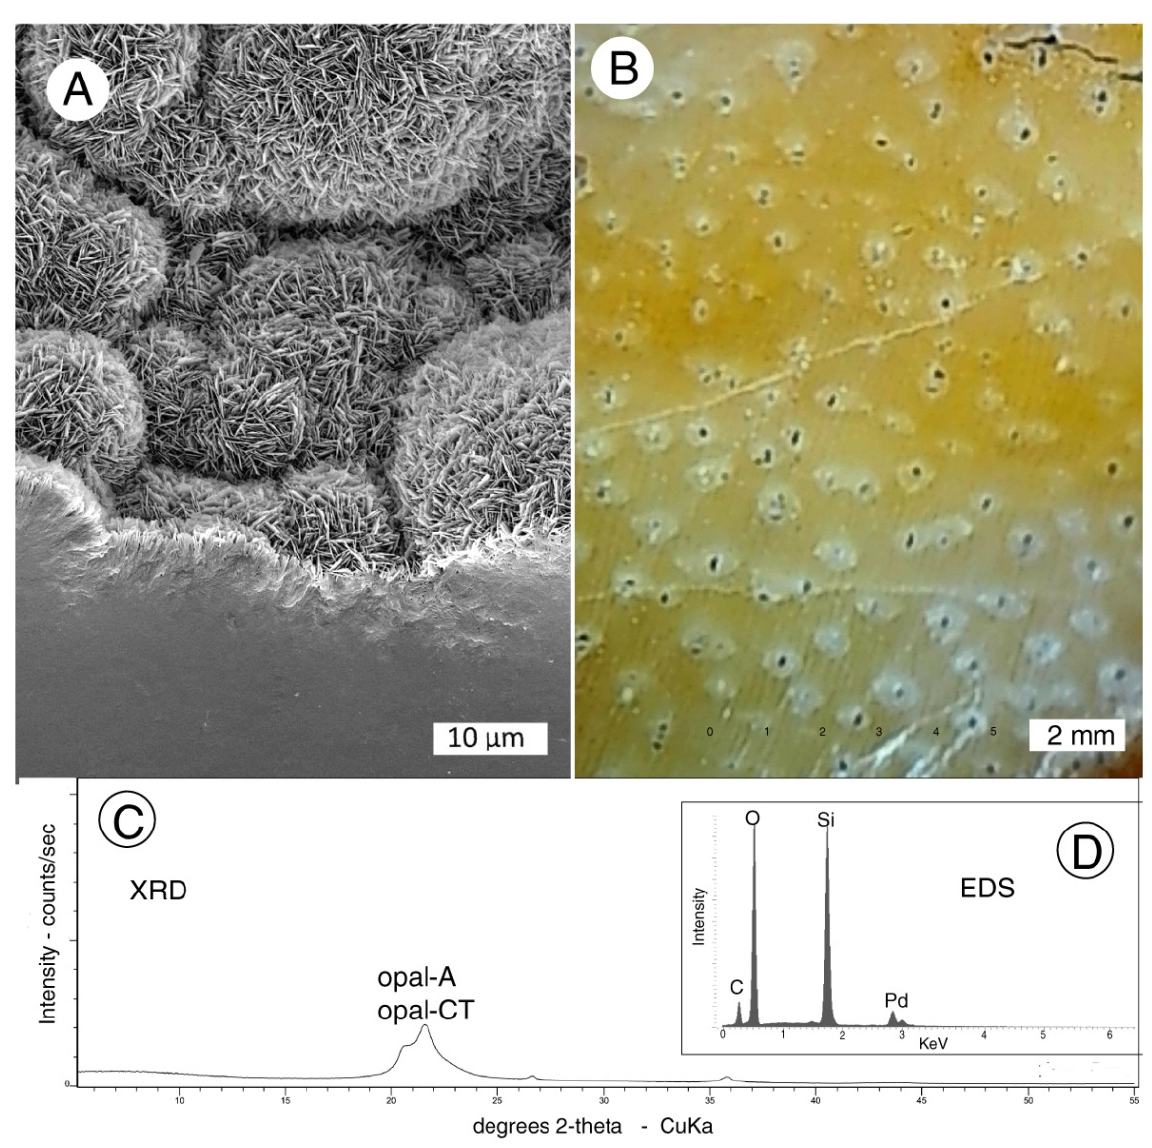
Figure 15. Microscopy and XRDS analysis of sample S-2 showing opal mineralization. ( A ) SEM image shows crystalline opal-CT lining a cavity. Adjacent smooth areas are presumably amorphous opal-A. ( B ) Transverse orientation shows preservation of vessels, evidence that this is angiosperm wood. ( C ) XRD pattern shows diffuse peaks characteristic of opal-CT. The very weak peaks of opal-A are obscured by the opal-CT peaks, but the overall low intensity of the diffraction pattern suggest that opal-CT is not the major constituent. ( D ) The SEM/EDS spectrum is nearly identical to that of specimen S-1, evidence that the X-ray fluorescence data do not distinguish between quartz and opal because both consist of SiO 2 . The inability to detect the presence of H precludes the possibility of recognizing hydrous opal.